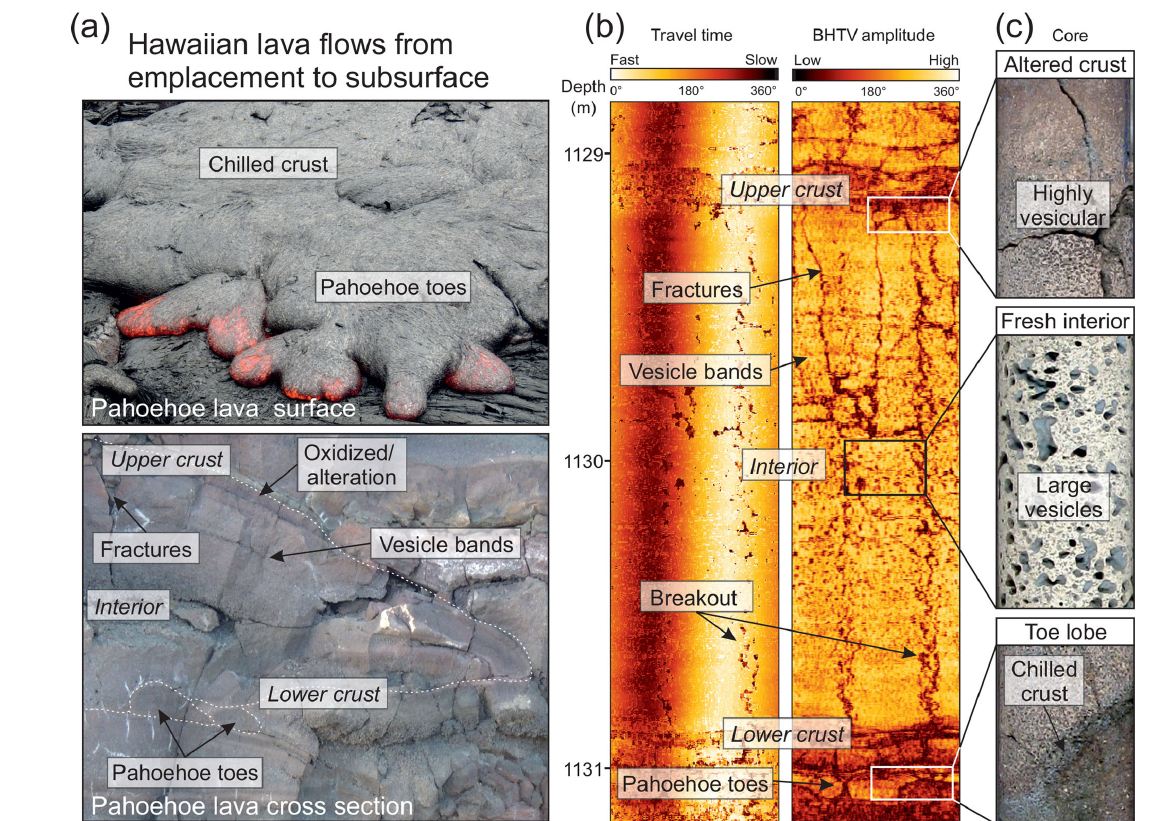
Figure 10. Examples of p¯ahoehoe and ‘a‘¯a facies: (a) from eruption and outcrop, (b) as imaged in televiewer, and (c) examples from the cored